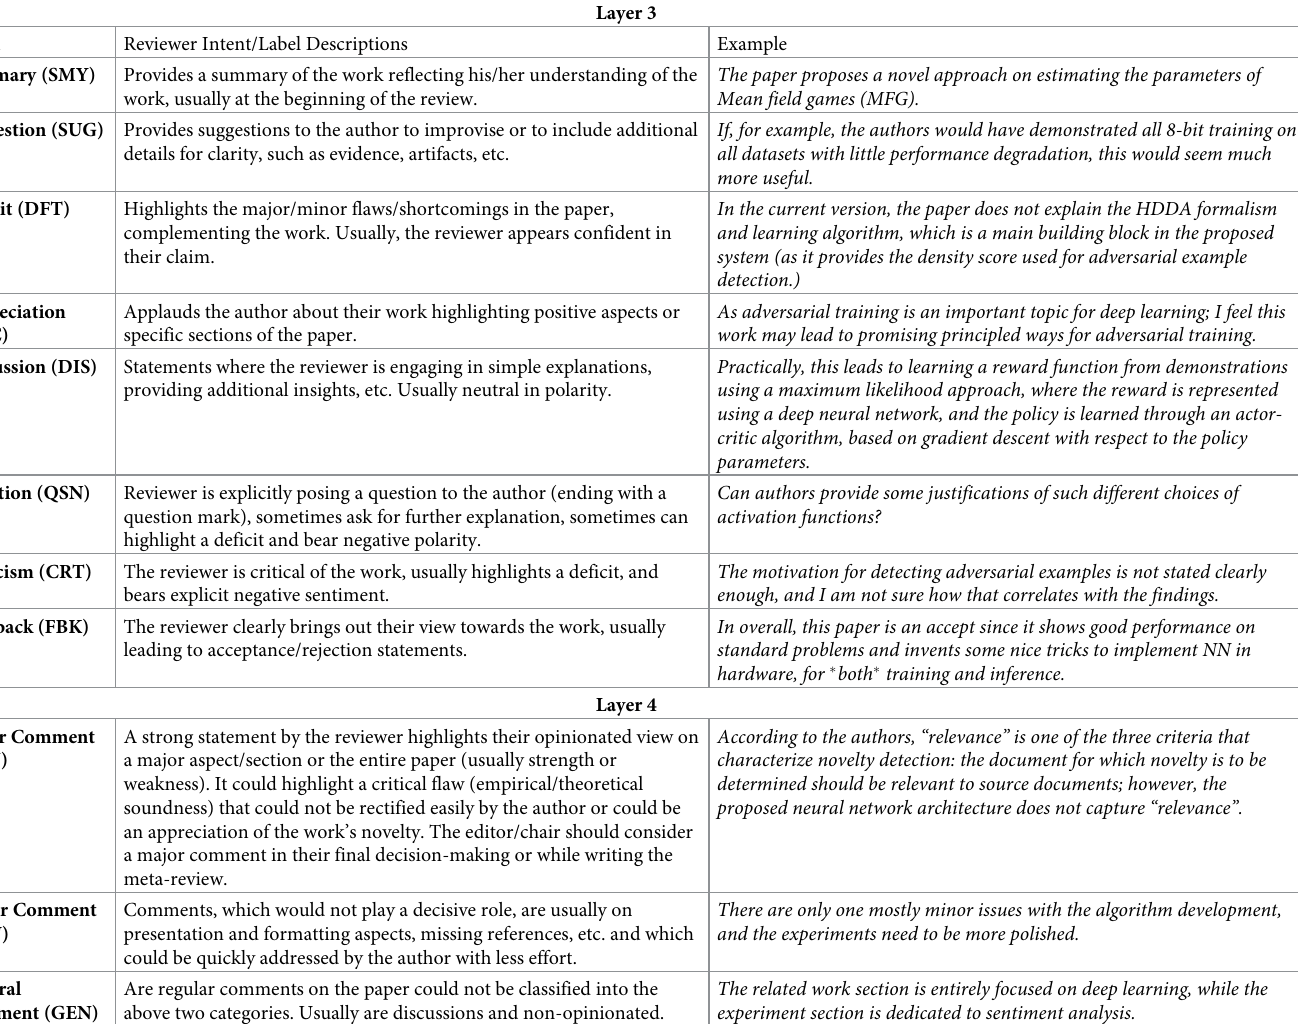
Table 3. Label descriptions and representative examples of review texts in review-statement purpose layer (Layer 3) and review-statement significance layer (Layer